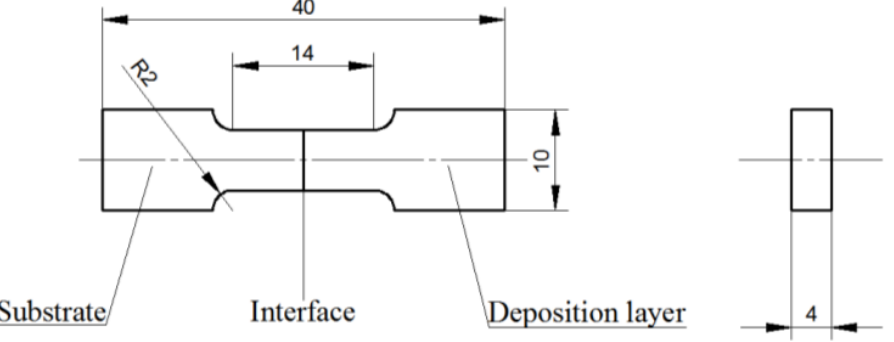
Figure 2. Illustration of tensile samples for testing bonding strength.